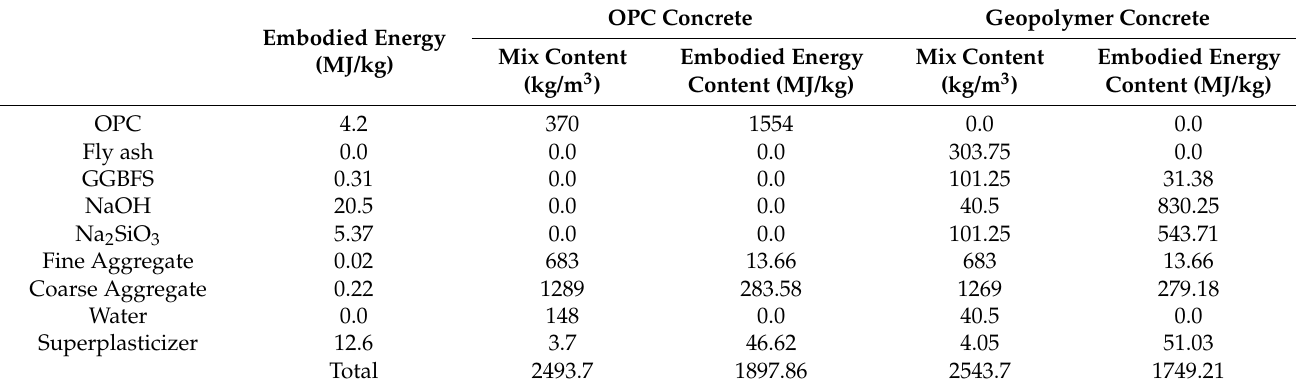
Table 2. GPC and OPC concrete constituents